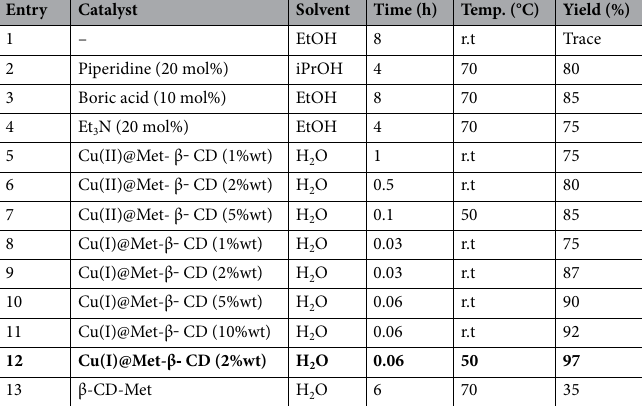
Table 1. Optimizing the catalyst amount and reaction condition. Significant values are in bold.